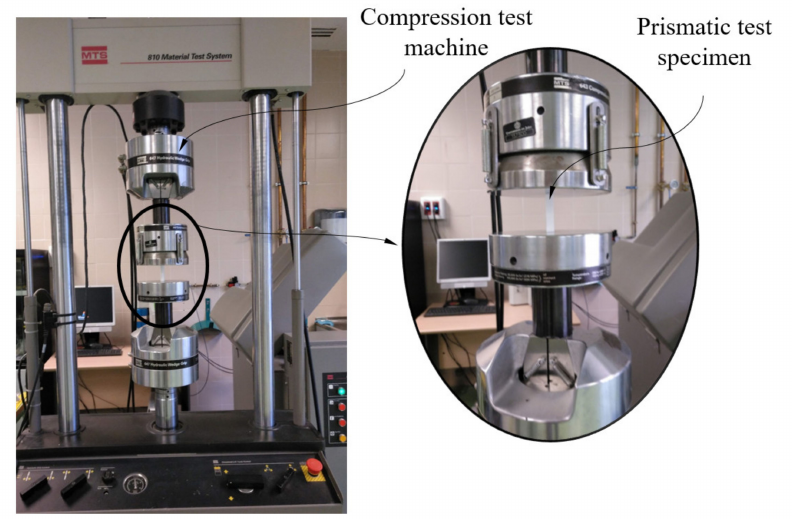
Figure 5. Test of uniaxial compression for specimens, testing machine